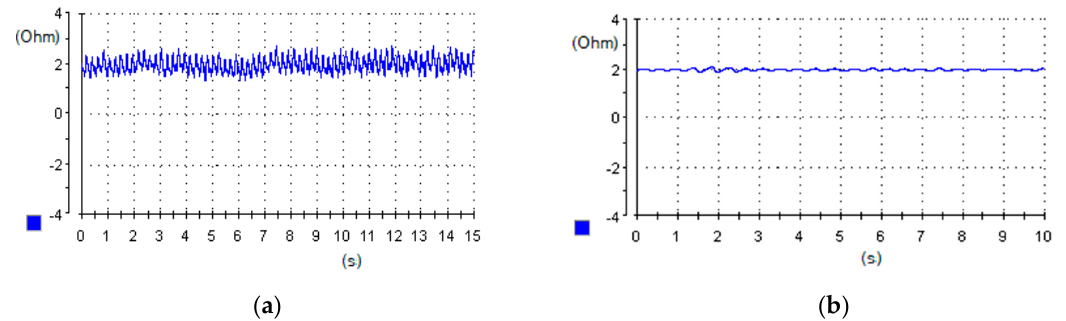
Figure 12. ( a ) Estimated stator resistance with learning rate is constant; ( b ) estimated stator resistance with learning rate as a function from Equation (18).